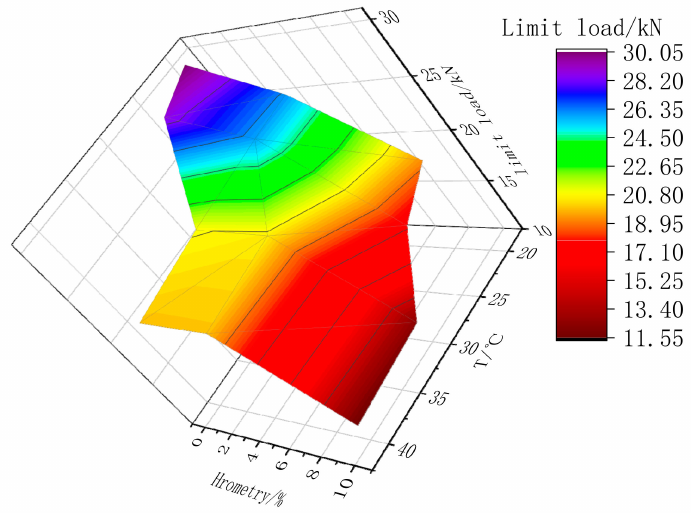
Figure 9. Limit loads under hygrothermal